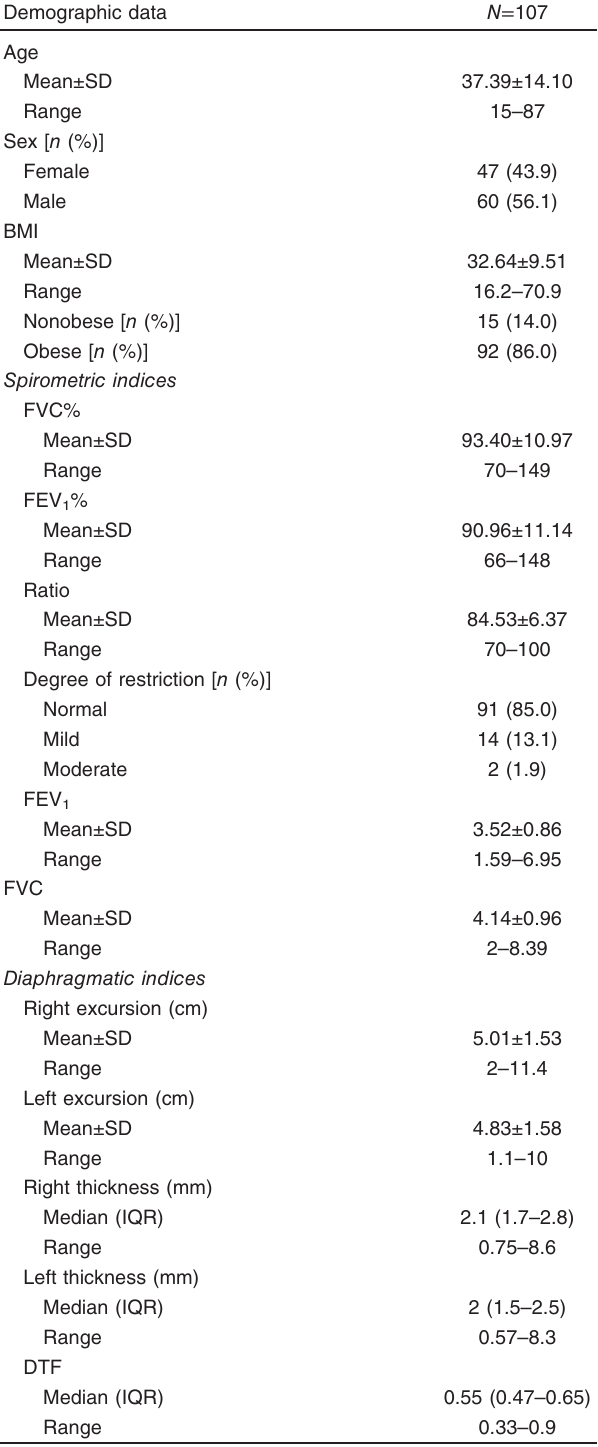
Table 1 Demographic data and spirometric and sonographic diaphragmatic indices of the studied population Demographic